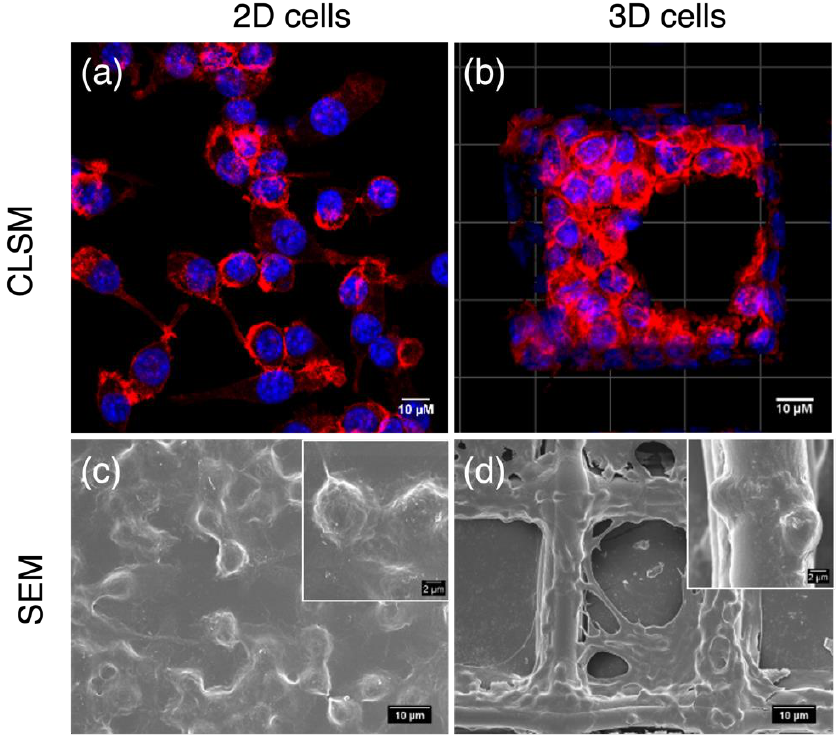
Figure 2. Morphologies of 2D- and 3D-cultured RAW264.7 cells. CLSM and FESEM images of 2D macrophages ( a , c ); CLSM and SEM images of macrophages cultured on PCL scaffolds ( b , d ). Blue: cell nuclei stained with H33342; red: F-actin stained with F-actin cytopainter.